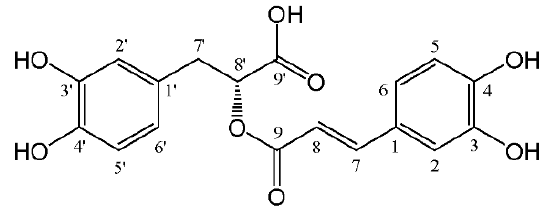
Figure 1. The chemical structure of RA.